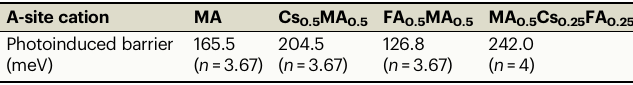
Table 1 | Summary of the photoinduced potential barriers in various mixed-dimensional 2D/3D HP systems A-site